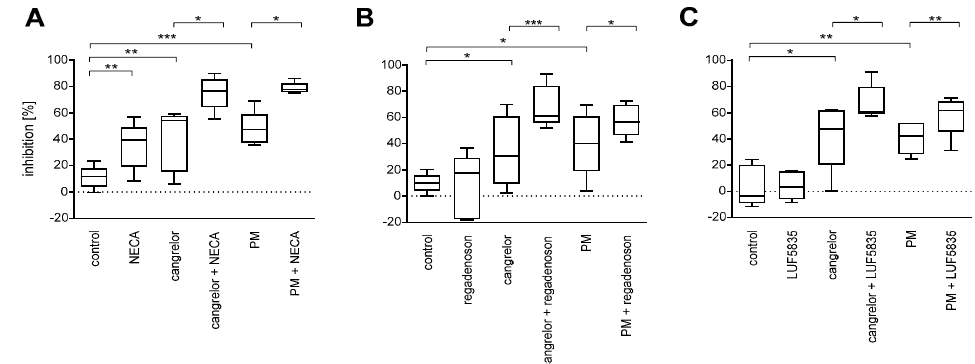
Figure 2. AR agonists intensify the anti-aggregatory e ff ect of P2Y 12 antagonists: NECA ( A ), regadenoson ( B ), and LUF5835 ( C ). Data are presented as median, interquartile range and minimum and maximum values ( n = 5 for each AR agonist; totally n = 15). Changes in platelet aggregation were measured in whole blood in response to 10 µ M ADP after 3 min preincubation at 37 ◦ C with AR agonist and cangrelor, or 15 min preincubation at 37 ◦ C with PM. Statistical significance was estimated by repeated measures ANOVA with Bonferroni’s multiple comparison test, or Friedman’s test with Dunn’s multiple comparison test depending on data distribution. * p < 0.05, ** p < 0.01, *** p < 0.005.